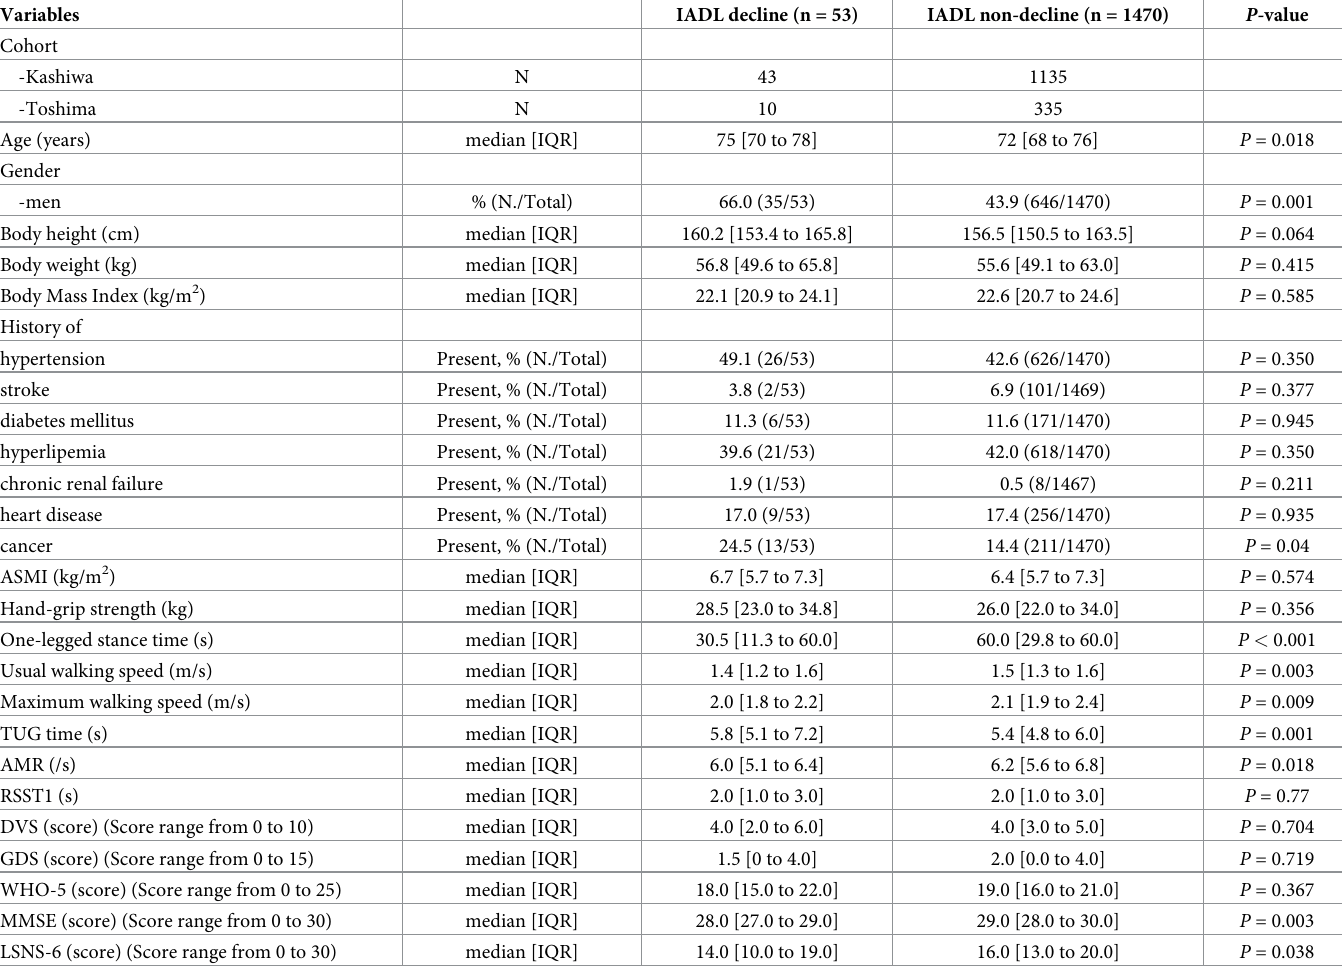
Table 2. Baseline characteristics of participants of IADL decline and IADL non-decline